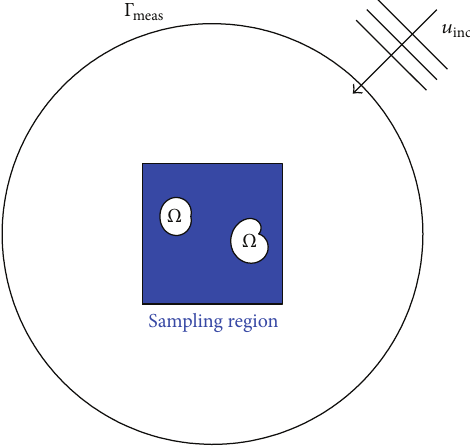
Figure 1: Scheme of the inverse